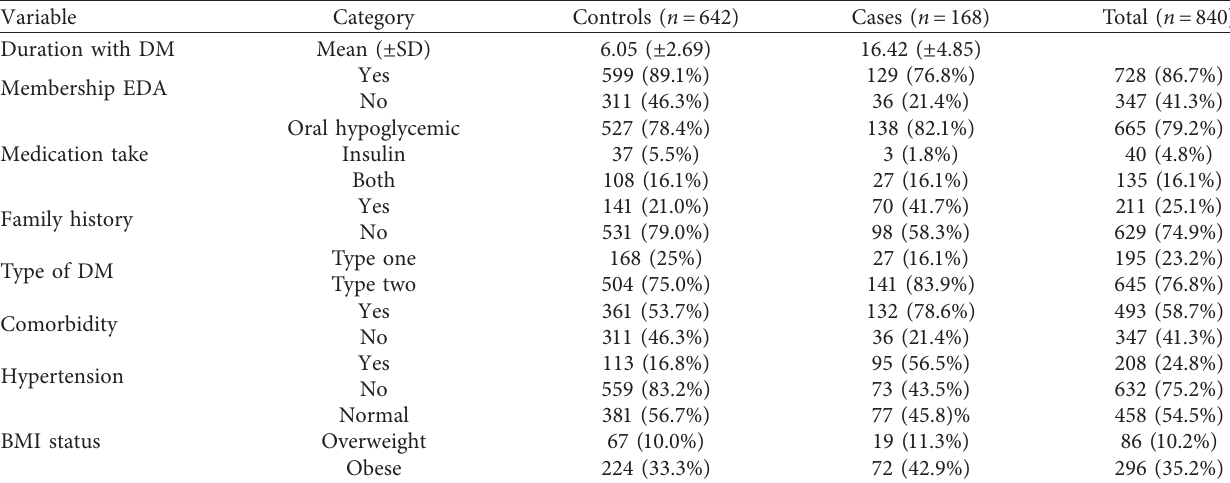
Table 2: Health profile of the study participants on follow-up at public hospitals of Tigray, Ethiopia,